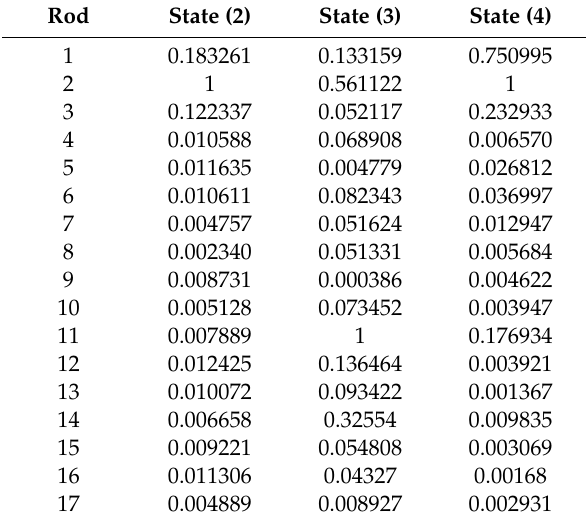
Table A1. The change rate of the modal strain energy (MSECR) under each case based on accelerometers.